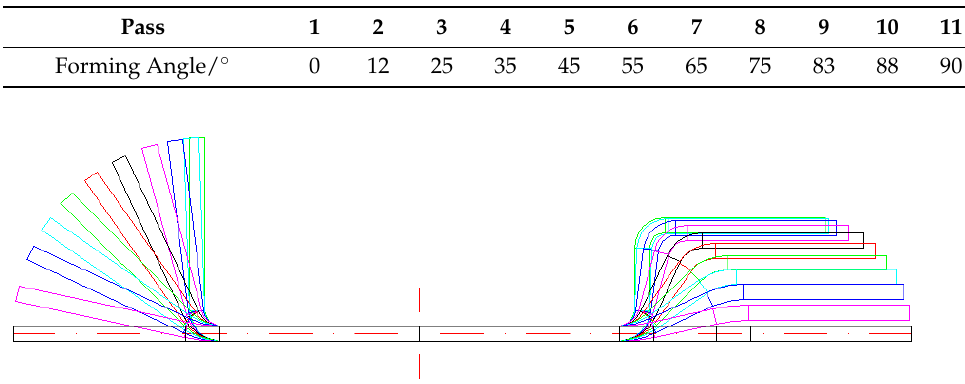
Figure 5. Setting of boundary conditions of the lower beam model.